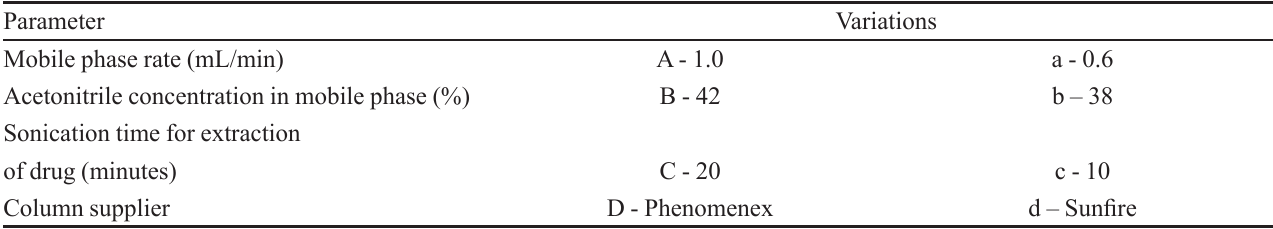
TABLE I - Parameters and variations to evaluate the robustness of the chromatography method